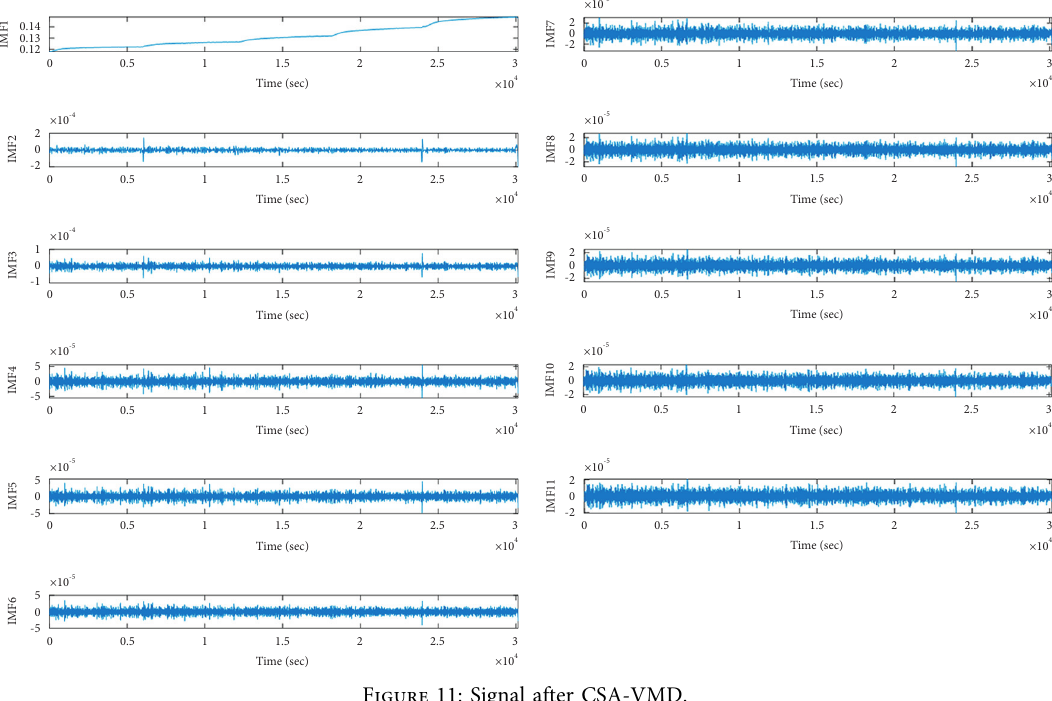
Figure 11: Signal after CSA-VMD.